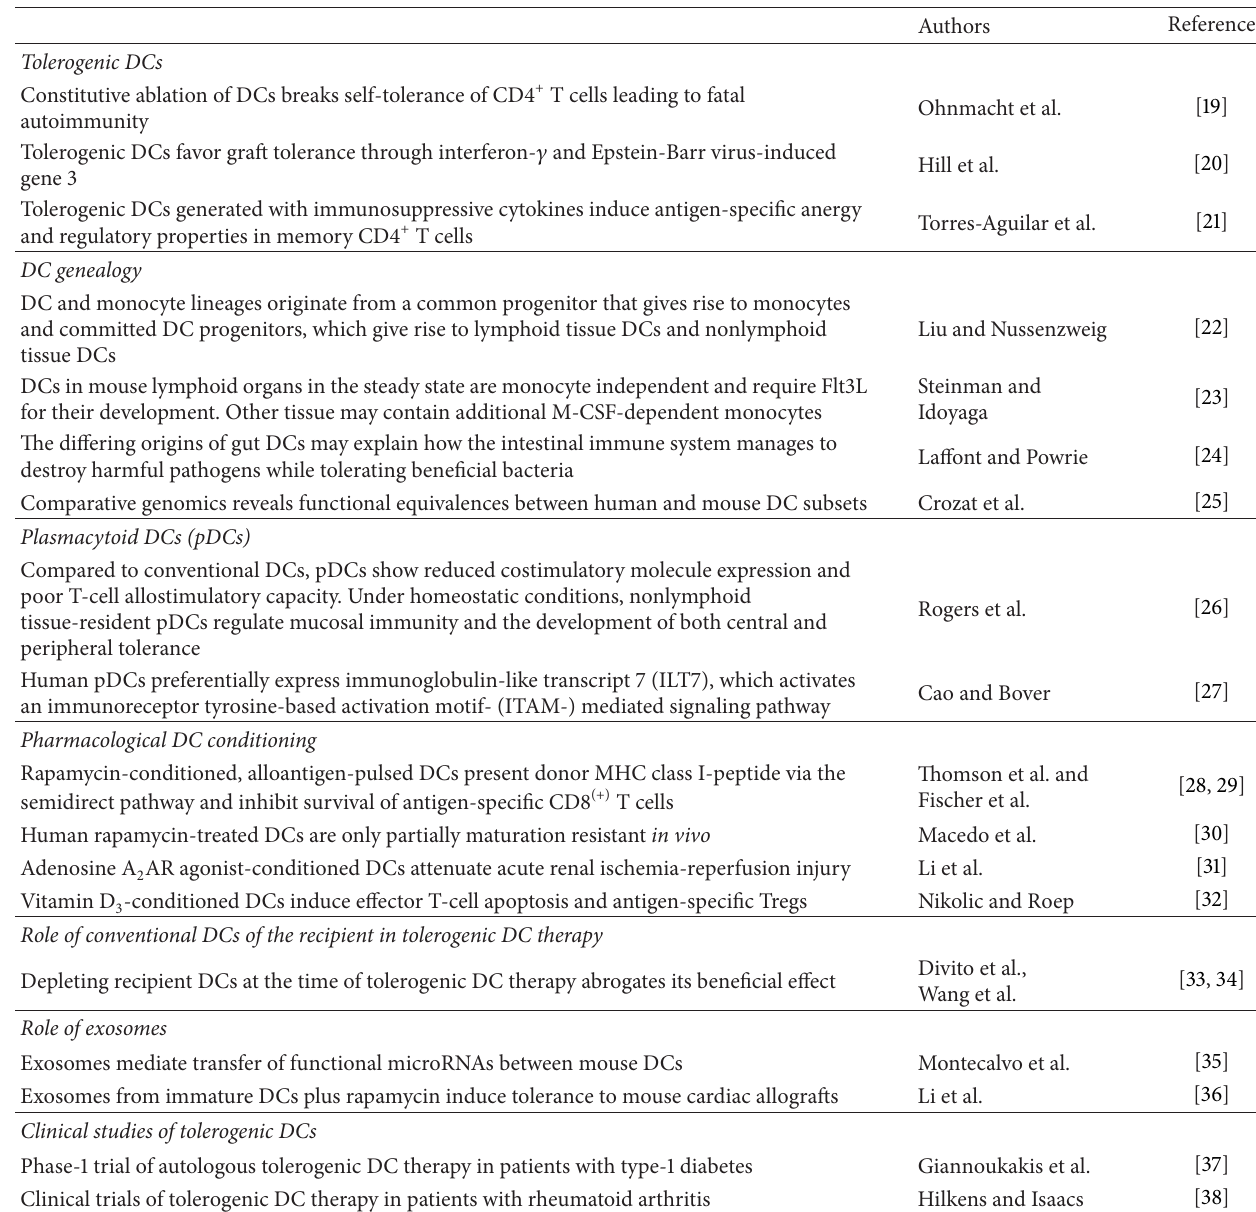
Table 1: Recent advances in DC biology, tolerogenic DCs, and pharmacological conditioning